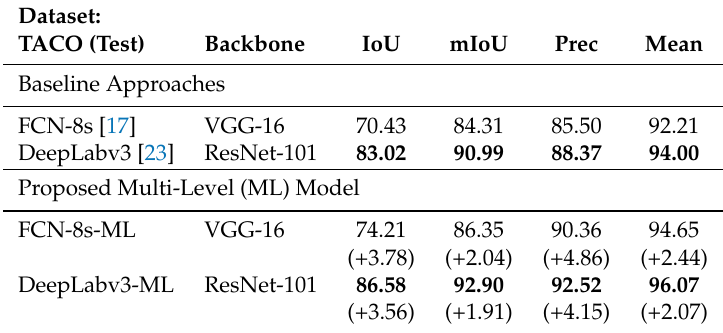
Table 6. Performance comparisons on the test set of TACO. For each method, we report the IoU for waste objects (IoU), mean IoU (mIoU), pixel Precision for waste objects (Prec) and mean pixel precision (Mean). See Section 4.4 for